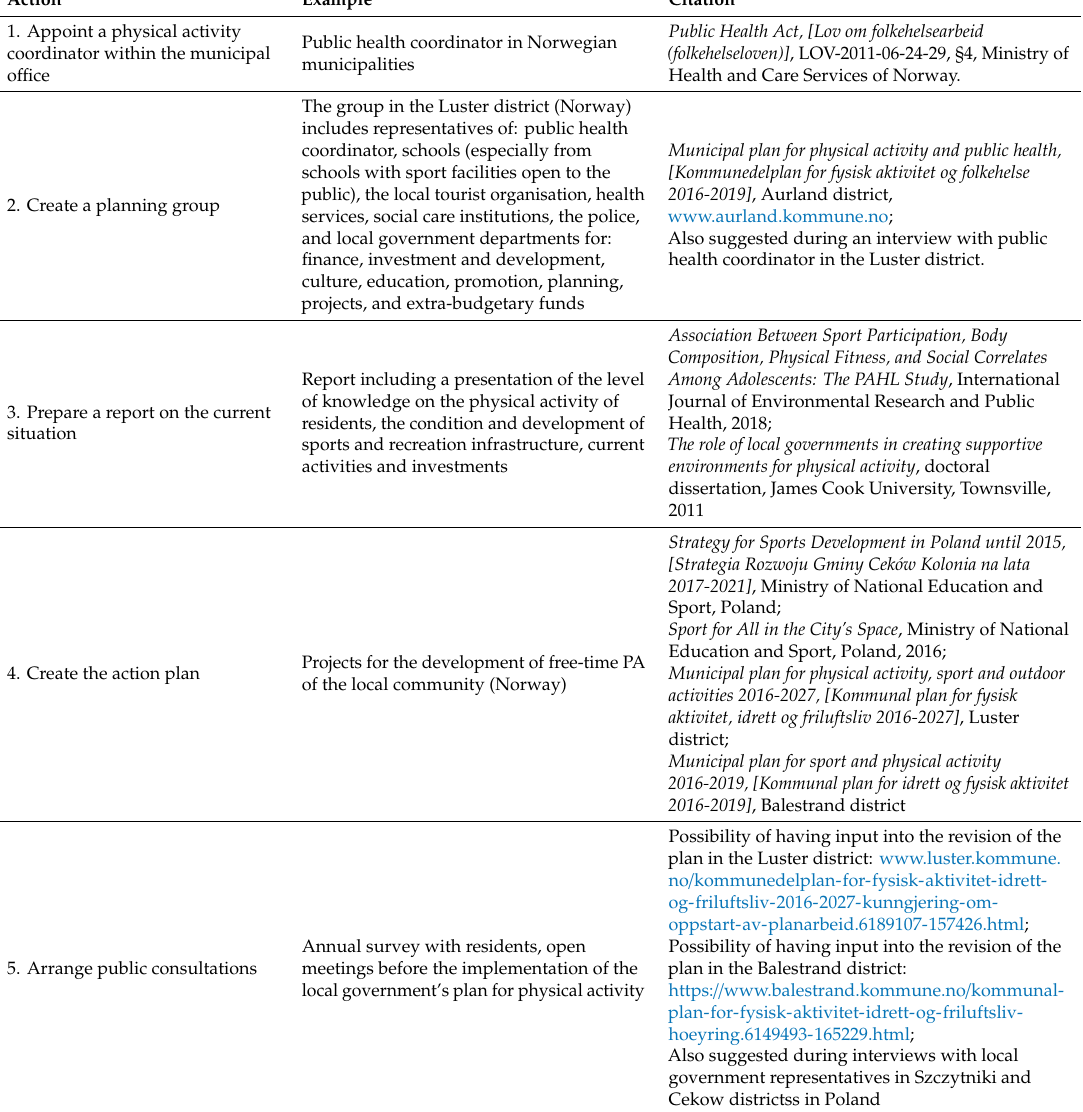
Table 5. Recommended model of operation of local authorities for the purpose of raising PA levels in the